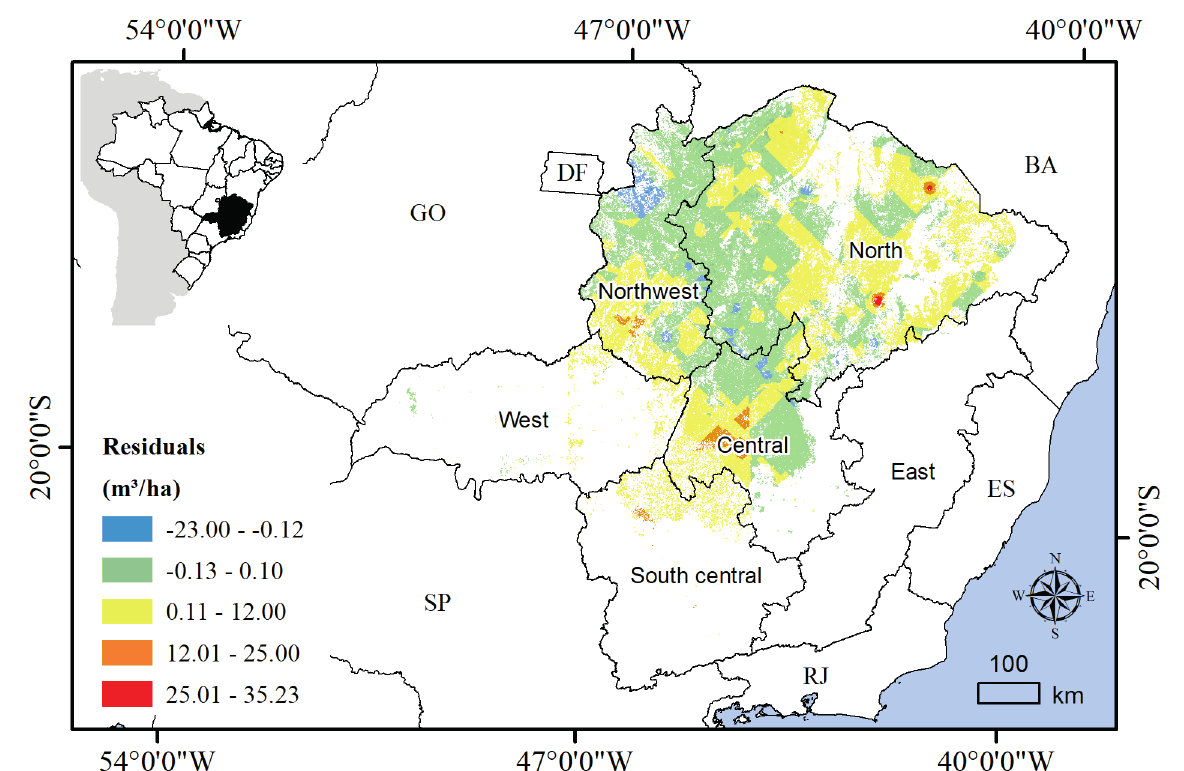
Figure 5 - Spatial distribution of wood volume residuals in Cerrado Sensu Stricto in the state of Minas